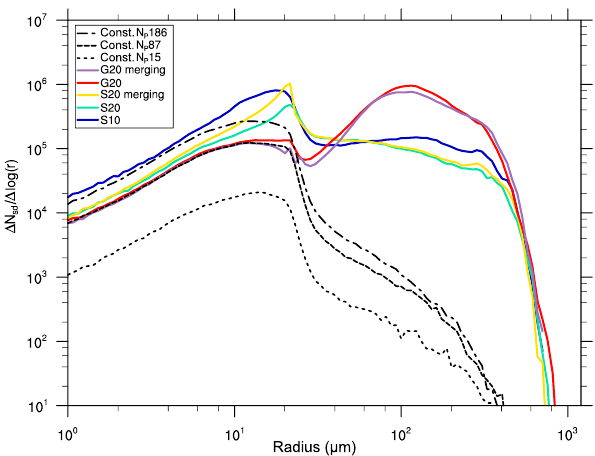
Figure 14. Total number of superdroplets per logarithmic radius bin after t = 1800s for the idealized single-cloud simulations using parameters described in Table